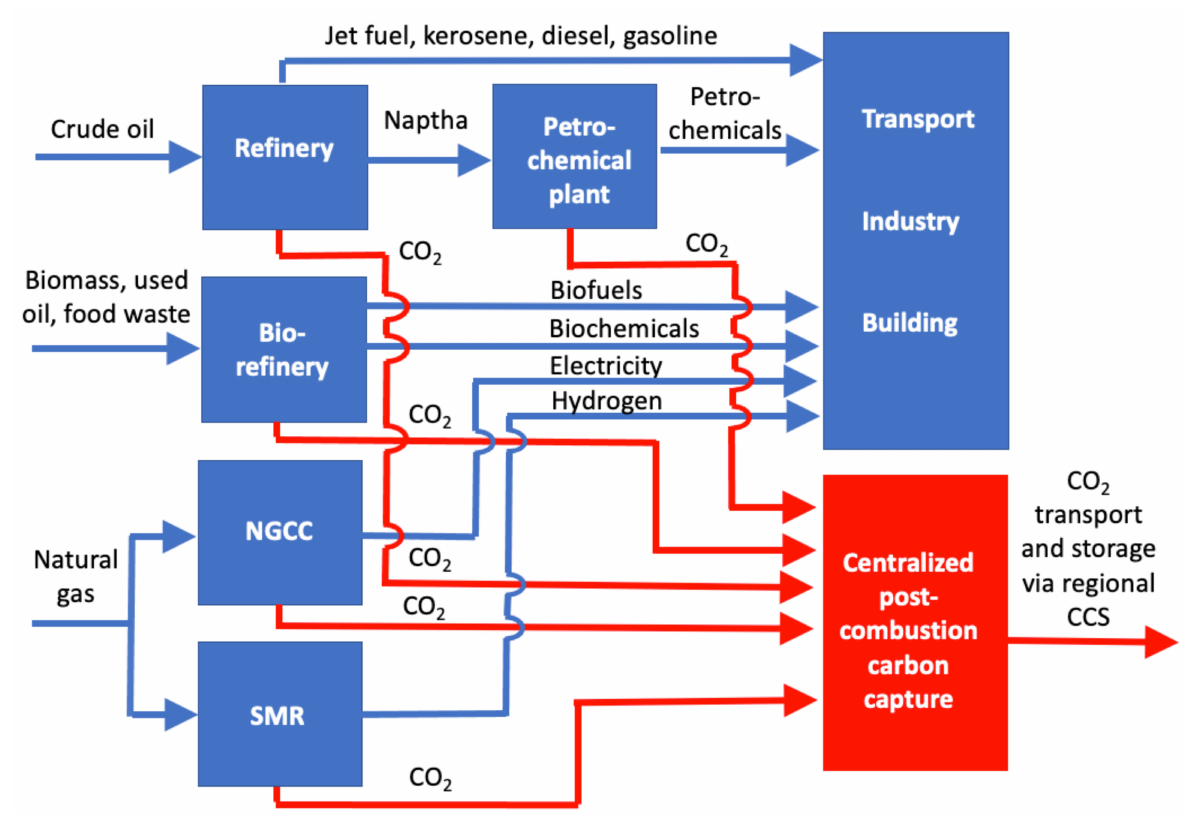
Figure 13. Future nexus between the power, refining, hydrogen, and petrochemical industries after